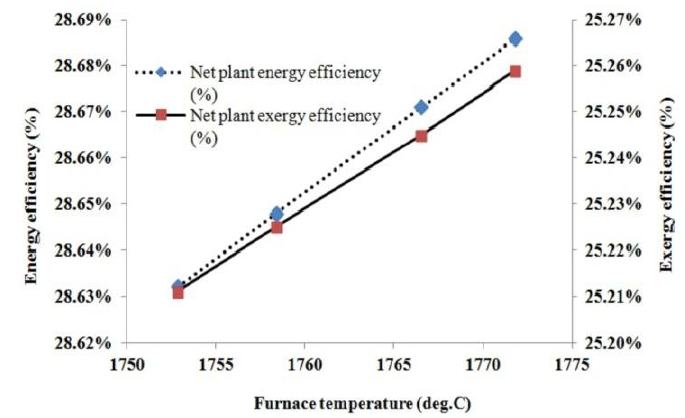
Figure 5. Flue gas recirculation vs. plant performance